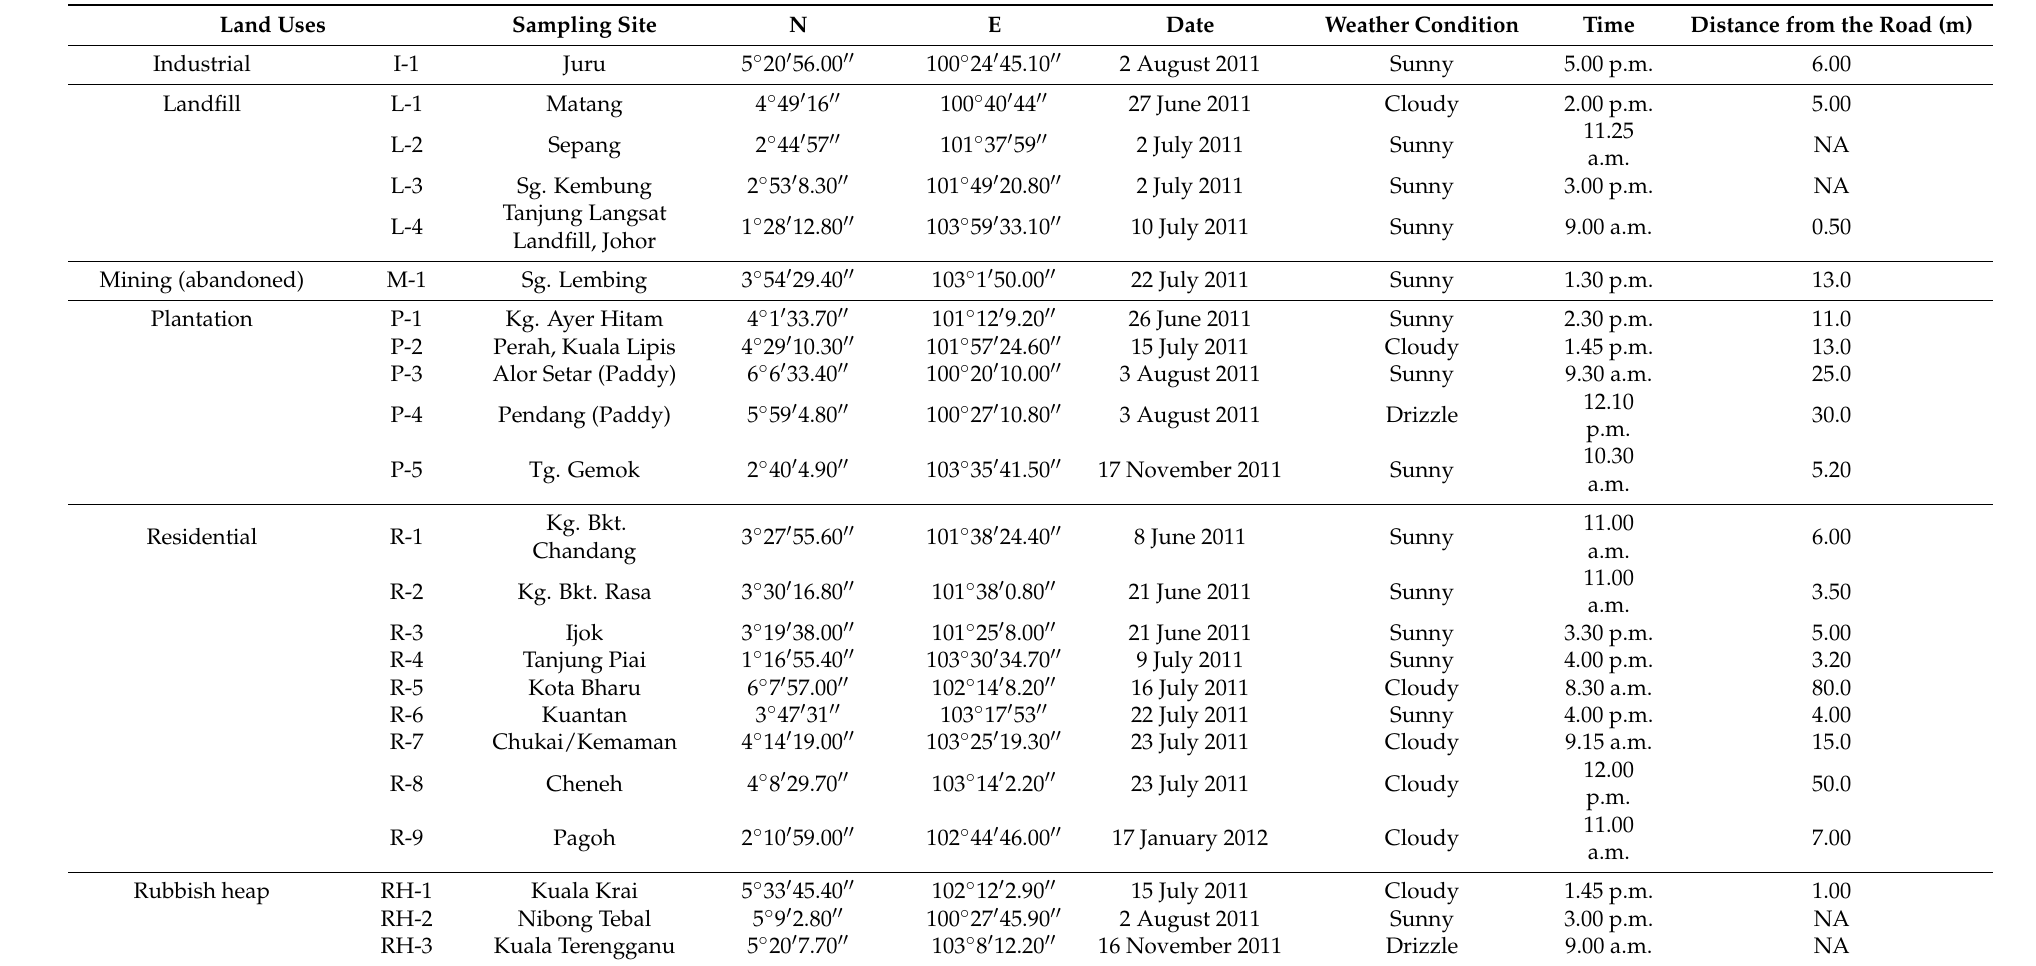
Table 1. Sampling information for topsoils collected from different land uses in Peninsular